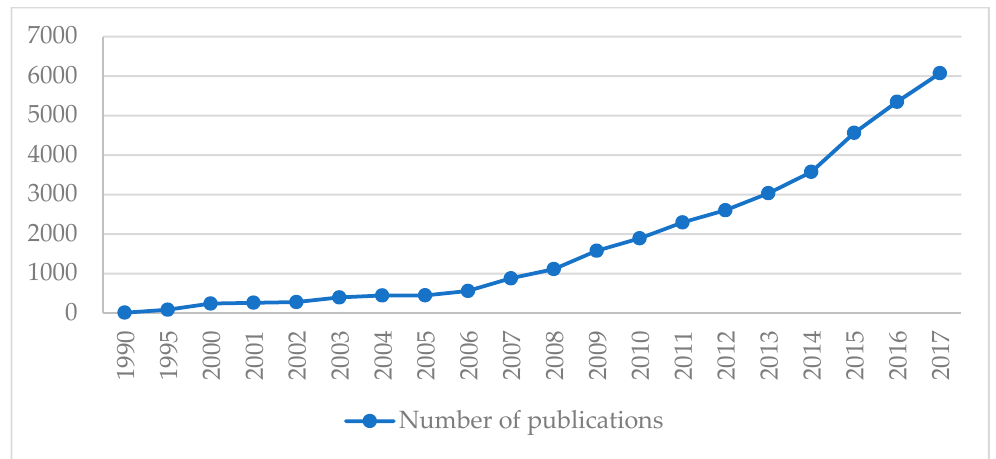
Figure 3. The publications on the topic “sustainable energy”, 1990–2017.